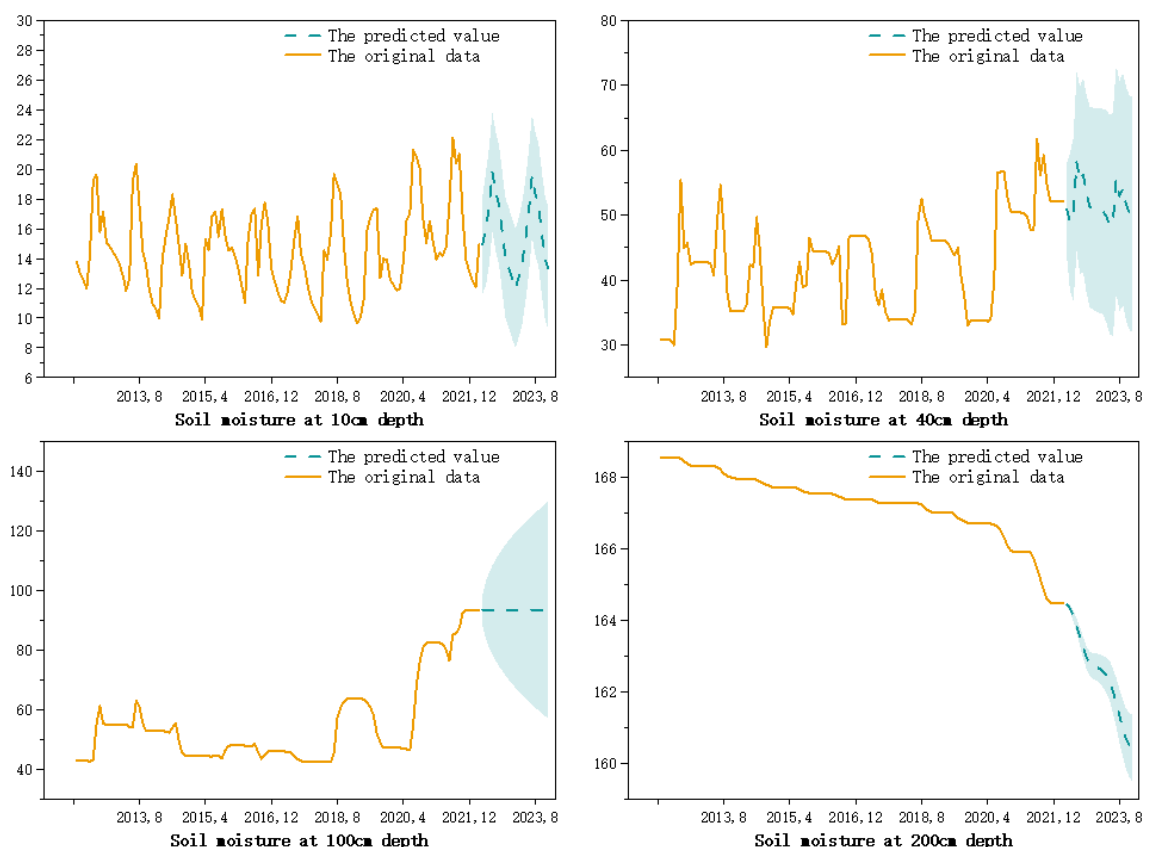
Figure 6. Soil moisture prediction results, based on the seasonal ARIMA model with a 95% confi- dence interval.